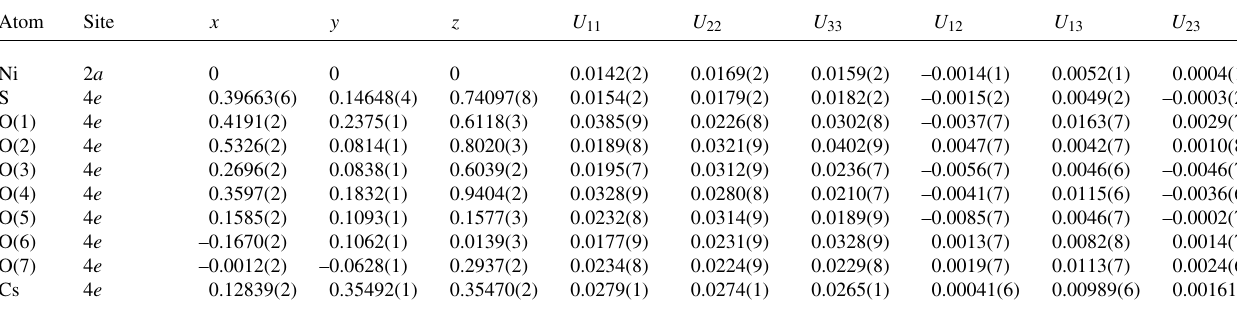
Table 15. Atomic coordinates and displacement parameters (in Å 2 ) .